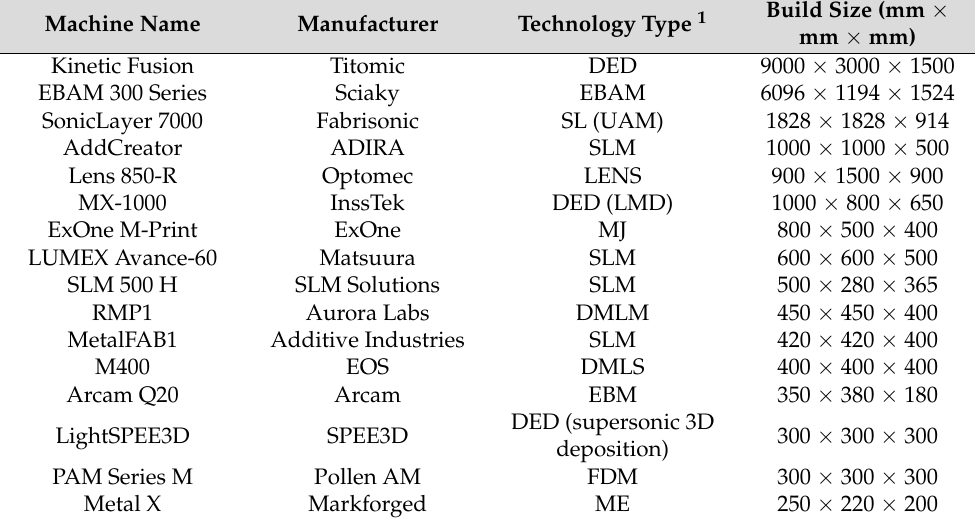
Table 2. Metal AM machines for fabrication of large